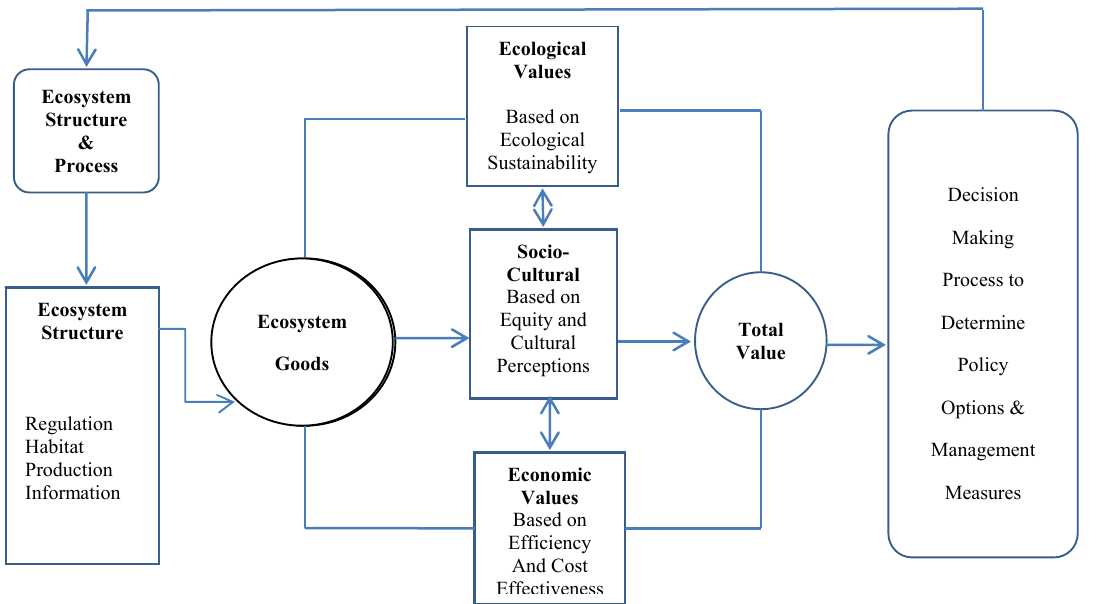
Figure 2. Framework for total economic value valuation. Adapted from De Groot et al.